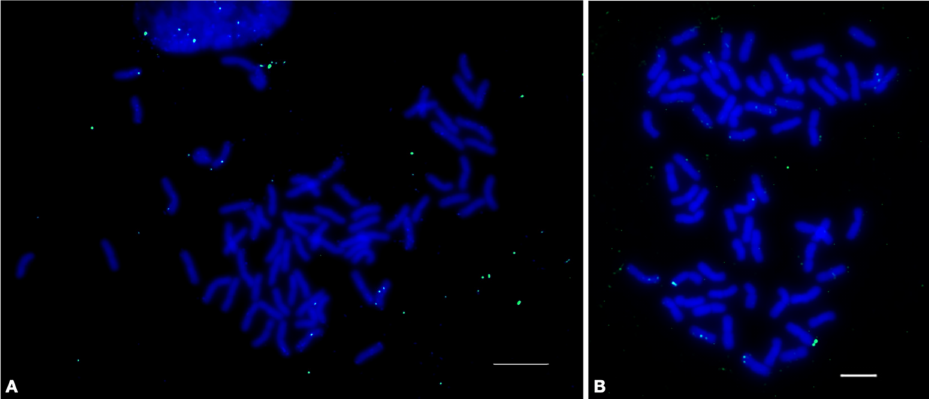
Figure 8. Localization of the 19-202 tandem repeat on the metaphase chromosomes of ( A ) Thinopyrum ponticum PI 693508 and ( B ) Thinopyrum ponticum 1158A/19 using fluorescence in situ hybridization. Green signals indicate the chromosomal localization of the 19-202 tandem repeat. The bar indicates 10 µ